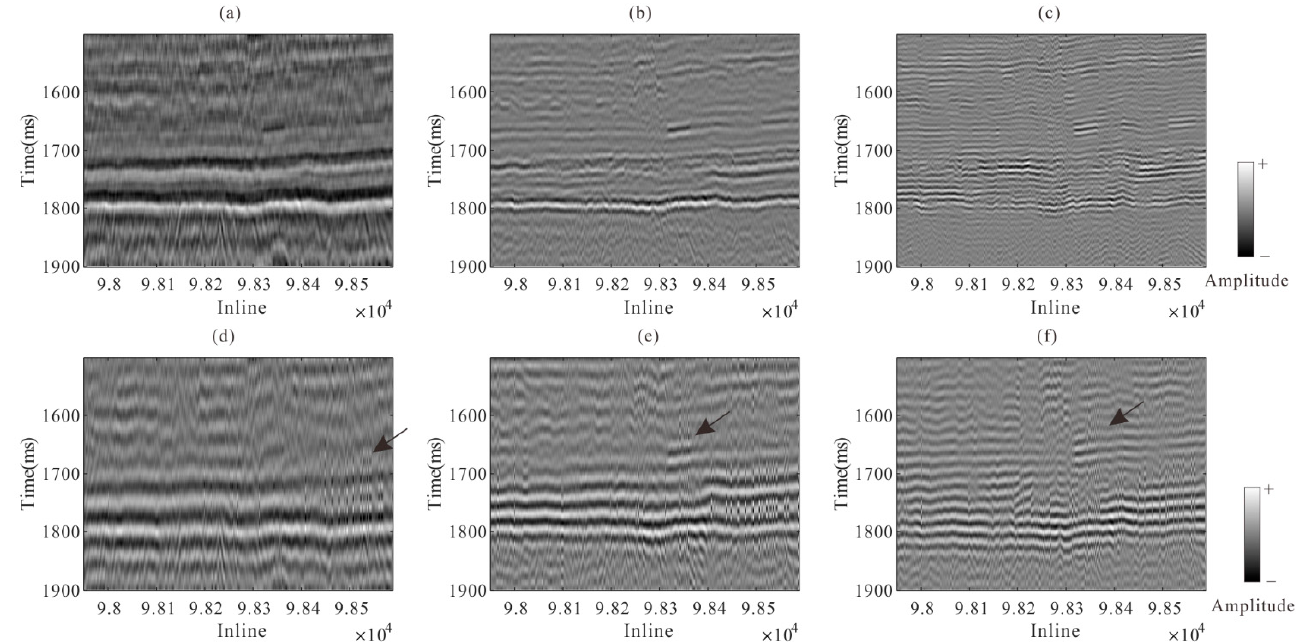
Figure 6. The RMS amplitude slices at t = 1650 ms calculated by full bandwidth seismic dataset.